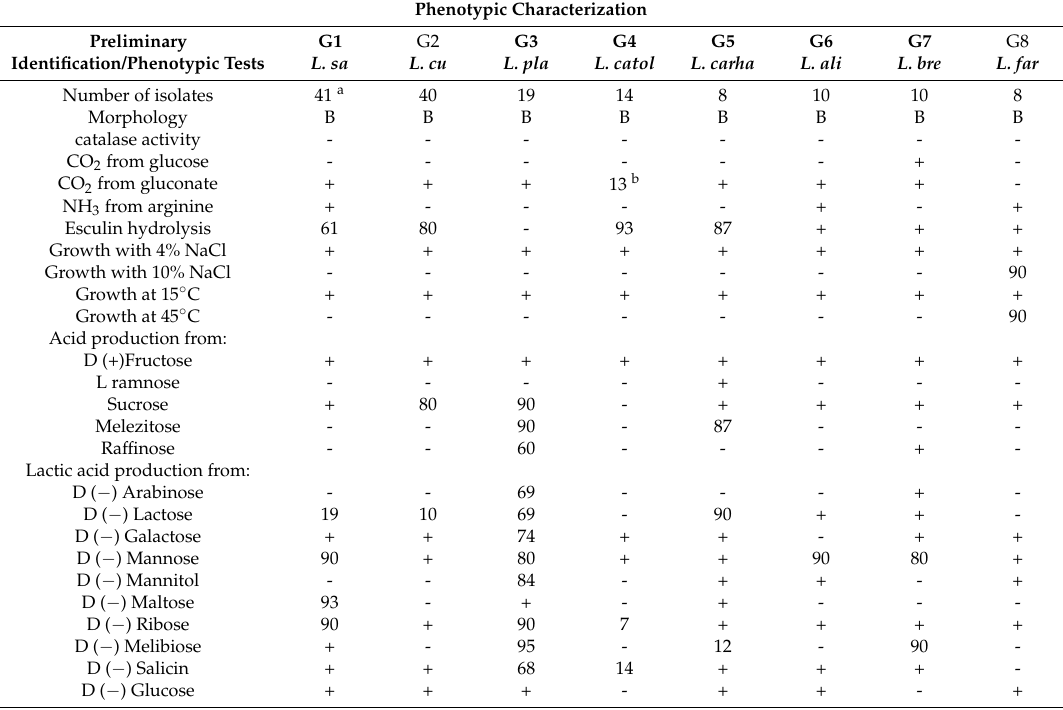
Table 4. Phenotypic properties of LAB isolated from spontaneously fermented sausages made with goat